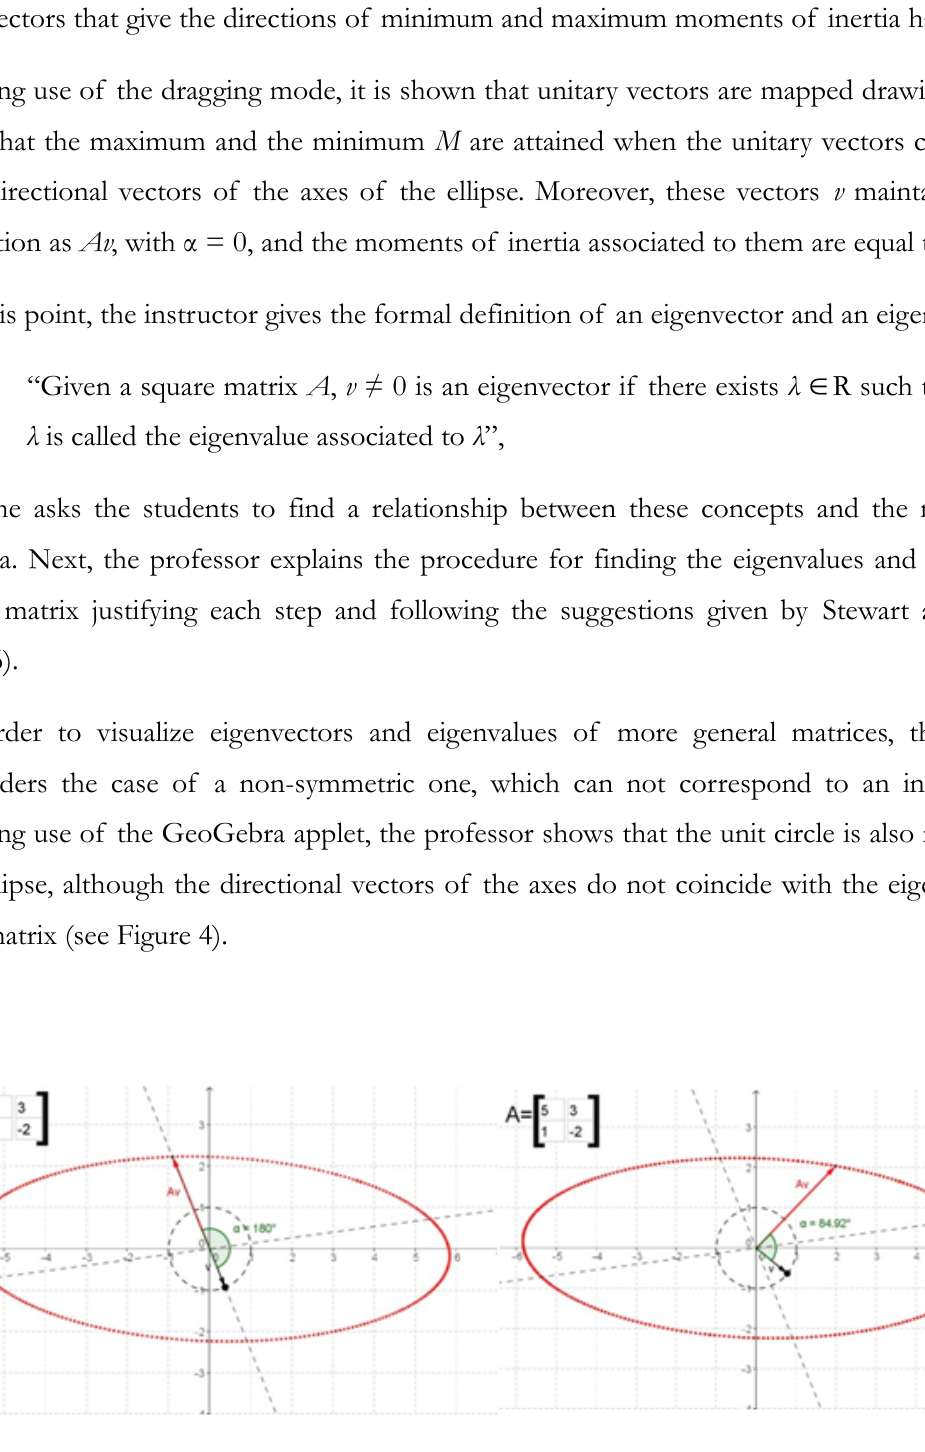
Figure 4. Non-symmetric matrix